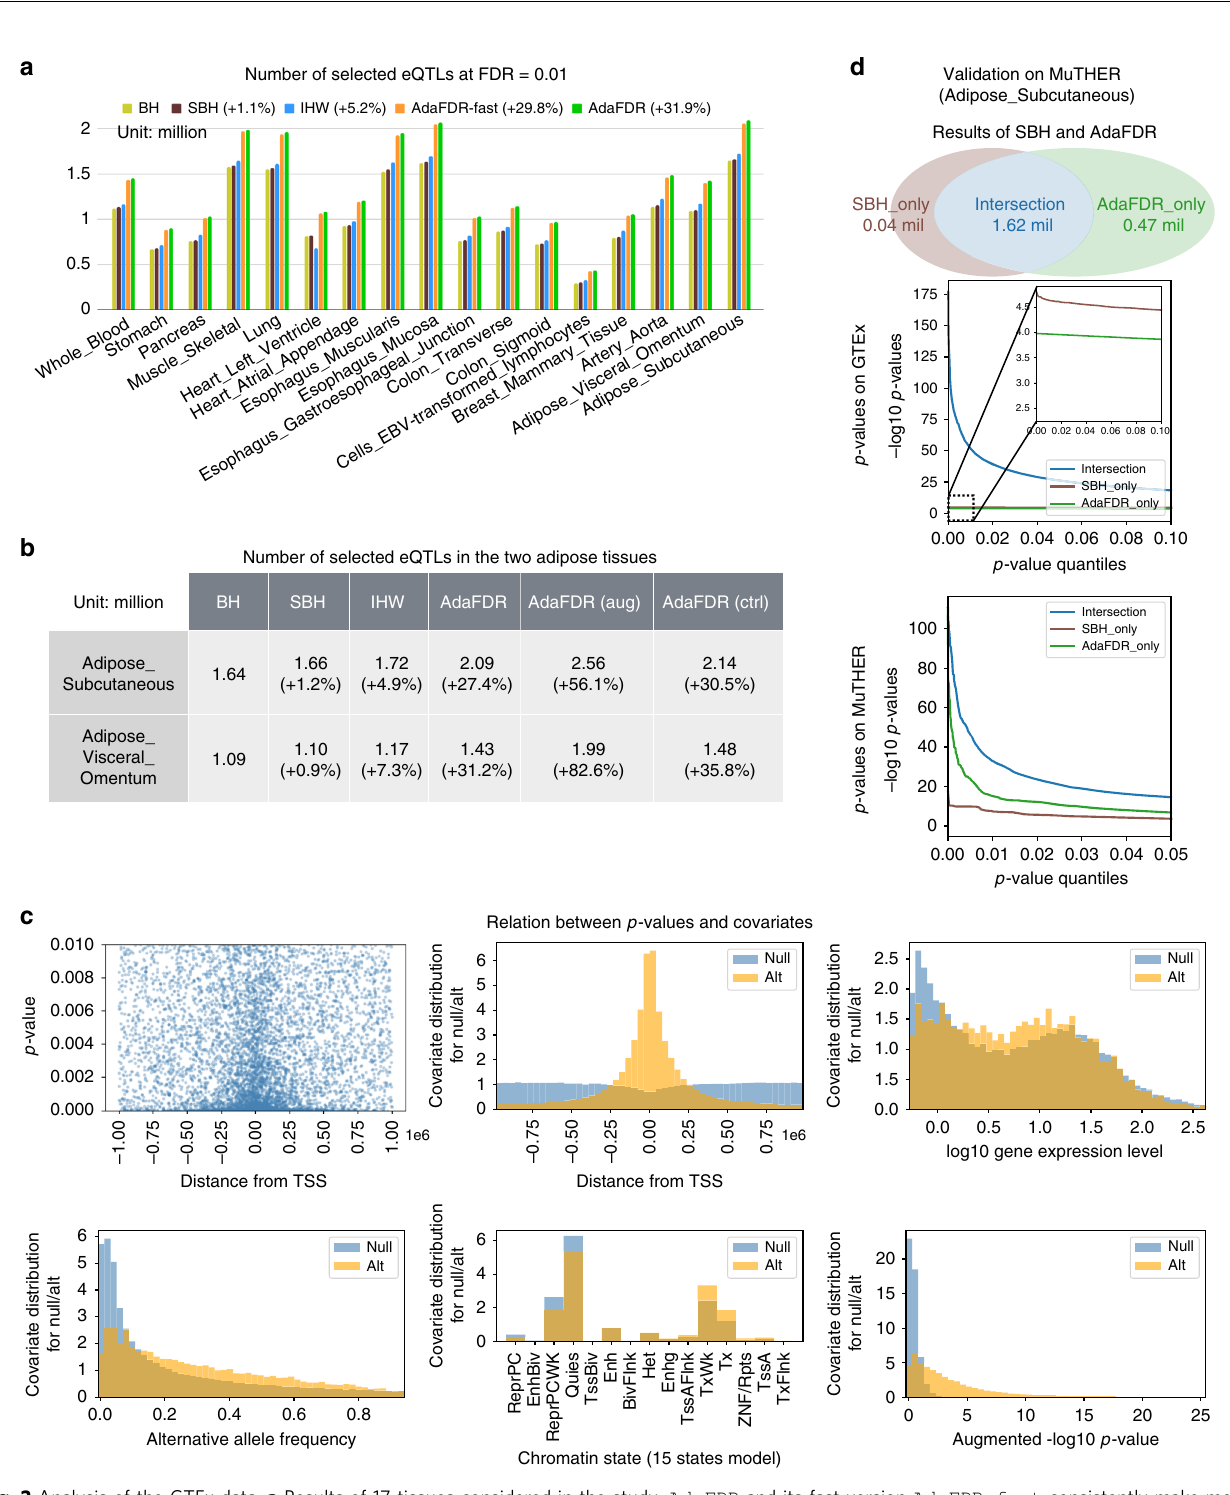
Fig. 2 Analysis of the GTEx data. a Results of 17 tissues considered in the study. AdaFDR and its fast version AdaFDR-fast consistently make more discoveries than other methods. Source data are provided as a Source Data fi le. b Results on the two adipose tissues where the − log10 p -value from another tissue was added as an extra covariate. Using p -values from a similar tissue ( AdaFDR (aug)) yields signi fi cantly more discoveries than using p -values from an unrelated tissue ( AdaFDR (ctrl)). c Top-left: p -values (y-axis) plotted against the distances from TSS ( x -axis); each dot corresponds to one SNP-gene pair. Small p -values at the center suggest that there is an enrichment of signi fi cant associations when the distance from TSS is small. Other panels: AdaFDR -estimated marginal covariate distribution for the null hypotheses (blue) and the alternative hypotheses (orange). Higher values of the orange distribution suggest an enrichment of alternative hypotheses. d Top: Discoveries made by SBH and AdaFDR . Middle: The p -values of these discoveries — SBH-only p -values are smaller than AdaFDR -only p -values on GTEx. Bottom: The p -values of the same set of discoveries on the independent MuTHER data, where AdaFDR -only p -values are smaller than SBH-only p -values, suggesting that AdaFDR -only discoveries are more likely to be